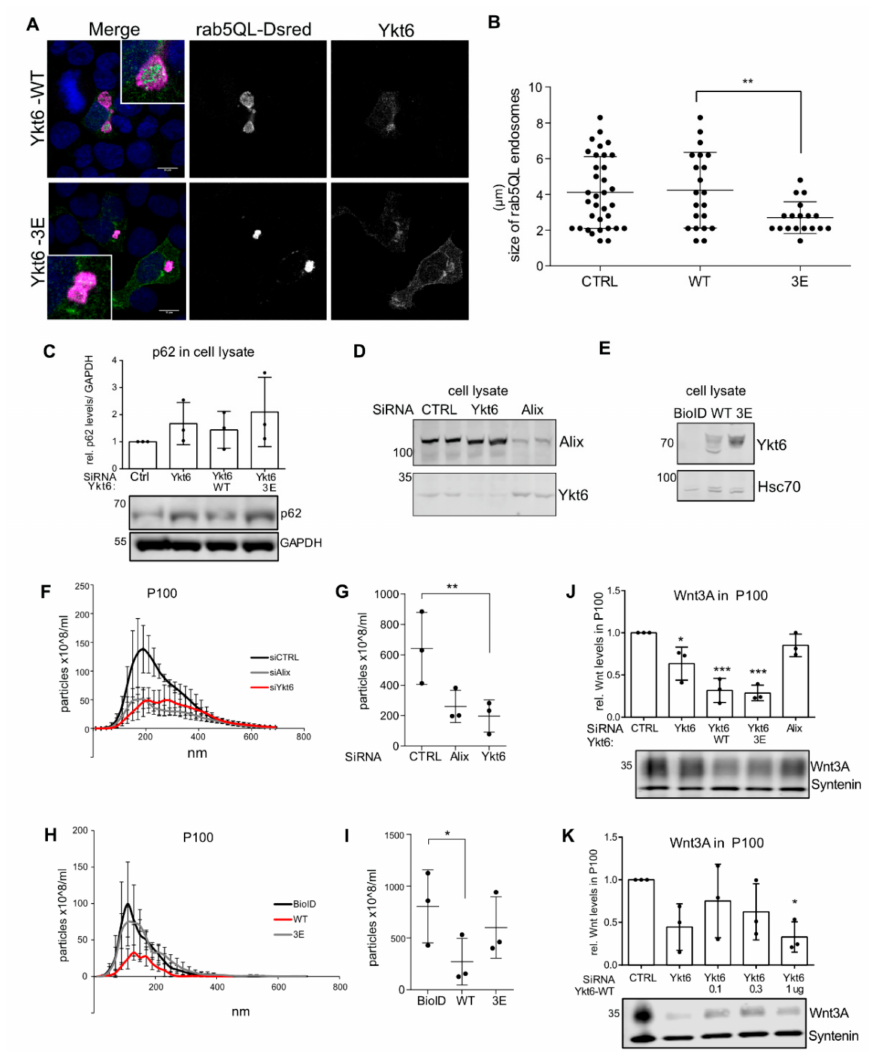
Figure 5. Ykt6 regulates extracellular vesicle (EV) secretion in a concentration-dependent manner. ( A ) Hek293T cells were co-transfected with plasmids for Rab5Q79L-DsRed and either control, Ykt6-WT, or Ykt6-3E and analyzed by immunofluorescence microscopy. Scale bar represents 10 µ m. ( B ) Quantification of ( A ), number of endosomes: control ( n = 34), Ykt6-WT ( n = 21), or Ykt6-3E ( n = 18) from two independent biological replicates. ( C ) Representative blot and quantifications of p62 levels in HCT116 cells transfected with siRNA against control or Ykt6 and Ykt6-WT or 3E. ( D ) Immunoblot of Hek293T cells transfected with siRNA against control, Ykt6, or Alix. ( E ) Immunoblot of Hek293T cells transfected with Ykt6-WT, -3E, and BioID mock plasmid. ( F ) Extracellular vesicles (EV) were purified from the supernatant. EVs in P100 are centrifuged 1 h at 100,000 × g . Size profile of P100-EV was analyzed by nanoparticle tracking analysis (NTA). ( G ) Quantification of 100–200 nm EV size profile in ( D ) from three biological replicates. Significance level ** = 0.01. ( H ) NTA EV size profile of P100 from ( F , I ) Quantification of 100–200 nm sized EVs from (G) from three biological replicates. * = 0.05. ( J , K ) Immunoblot and quantification of Wnt3A in P100 purified from Hek293T cells transfected with siRNA against control, Ykt6 or Alix and (J) Ykt6-WT or 3E, *** = 0.001 and ( K ) Ykt6-WT in three di ff erent concentrations (0.1, 0.3, and 1 µ g DNA) * =